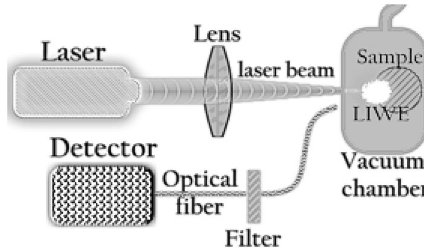
Figure 1. Scheme of LIWE measurement setup.